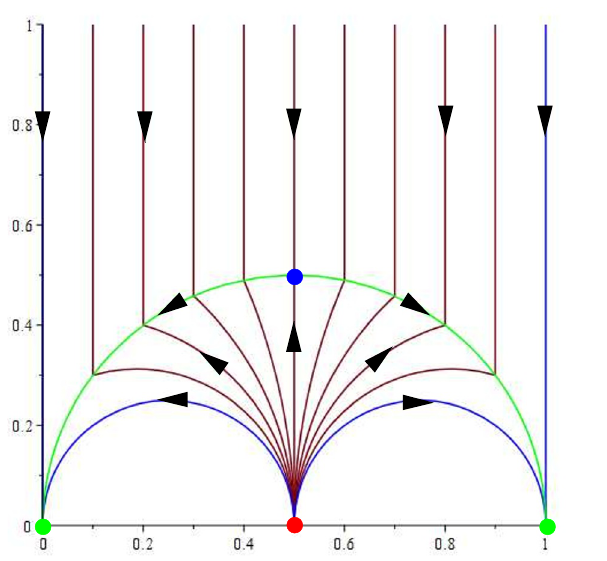
Figure 4 . Temperature flow of the conductivity on the event horizon for the group Γ 0 (2) . The fundamental domain can be taken to be the vertical strip 0 ≤ σ xy ≤ 1 above the green semi-circular arc of radius one-half, spanning 0 and 1 , the pattern repeats for σ xy → σ xy + n for any integer n . The temperature flow of the purely magnetic solution in the fundamental domain is shown together with one other copy obtained by applying the Γ (1 + i ) σ ∗ = 1 2